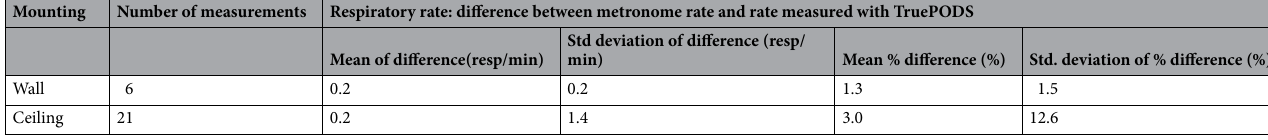
Table 3. Analysis of respiratory rate estimation accuracy.